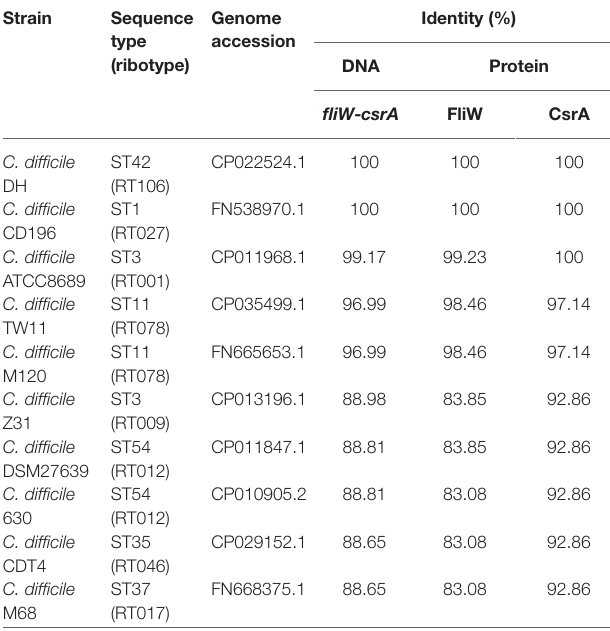
TABLE 2 | Alignments of fliW - csrA DNA and protein sequences in Clostridioides difficile strains.